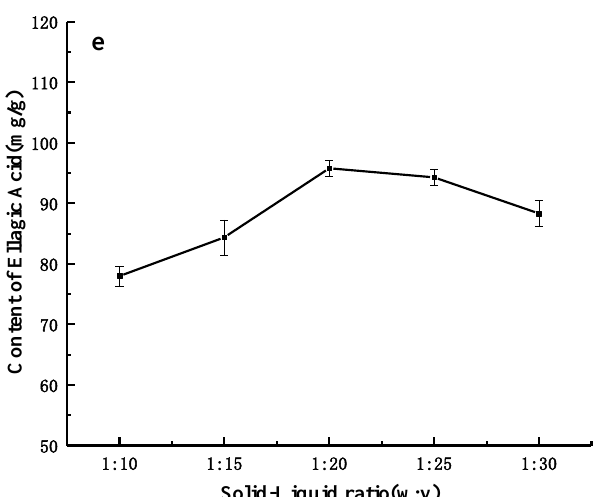
Figure 1. The influence of each single factor on the content of ellagic Acid in FB. ( a ) Fermentation time (h), ( b ) fermentation temperature (°C), ( c ) strain dosage ( v:v ), ( d ) glucose dosage (g/100 mL) and ( e ) solid–liquid ratio ( w:v ). Content of ellagic acid. Data shown as the mean ± S.D. ( n = 5).